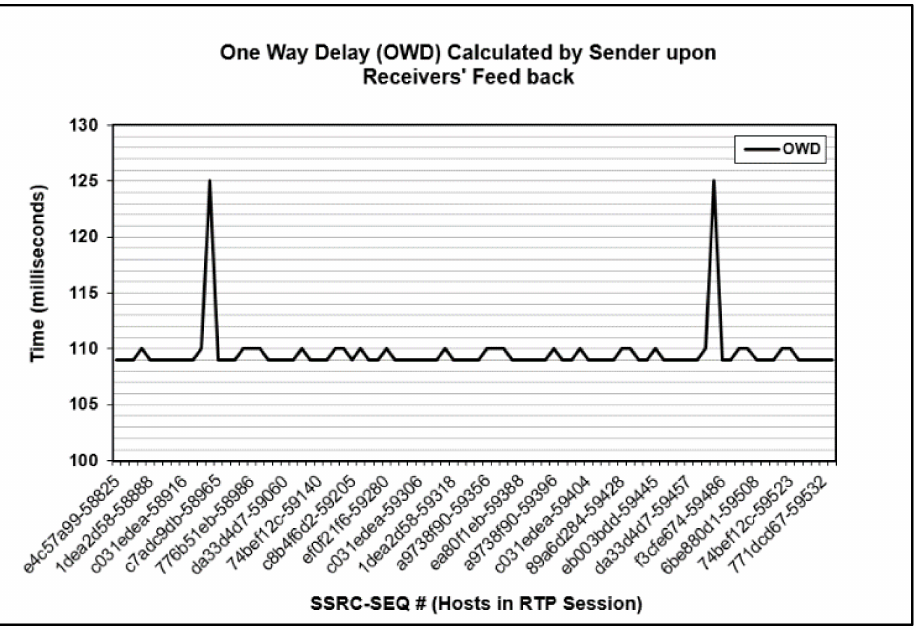
Figure 12. One-way delay (OWD) calculated at sender side using feedback from the